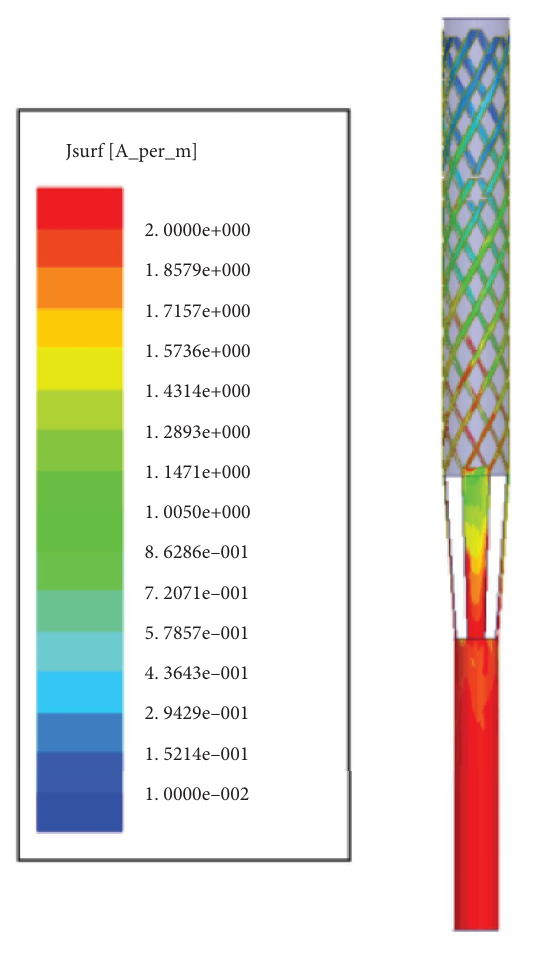
Figure 3: Surface current distribution of monopole antenna.